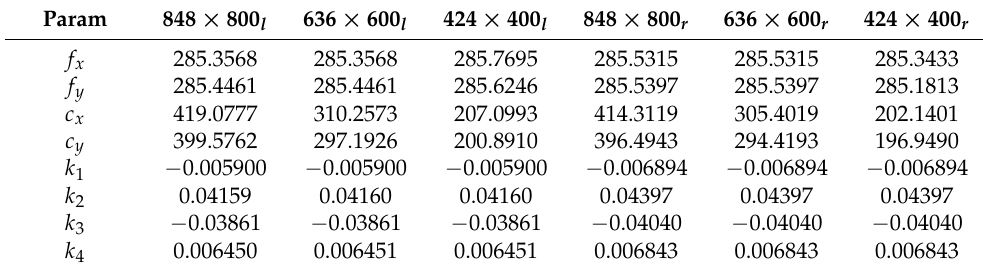
Table 2. Intrinsic and distortion parameters for left ( l ) and right ( r ) fisheye cameras for the three resolutions selected. The parameters f x and f y represent the focal length along X and Y. Instead, c x and c y are the principal point coordinates along X and Y. While k 1, k 2, k 3, k 4 are the distortion parameters of the equidistant camera model